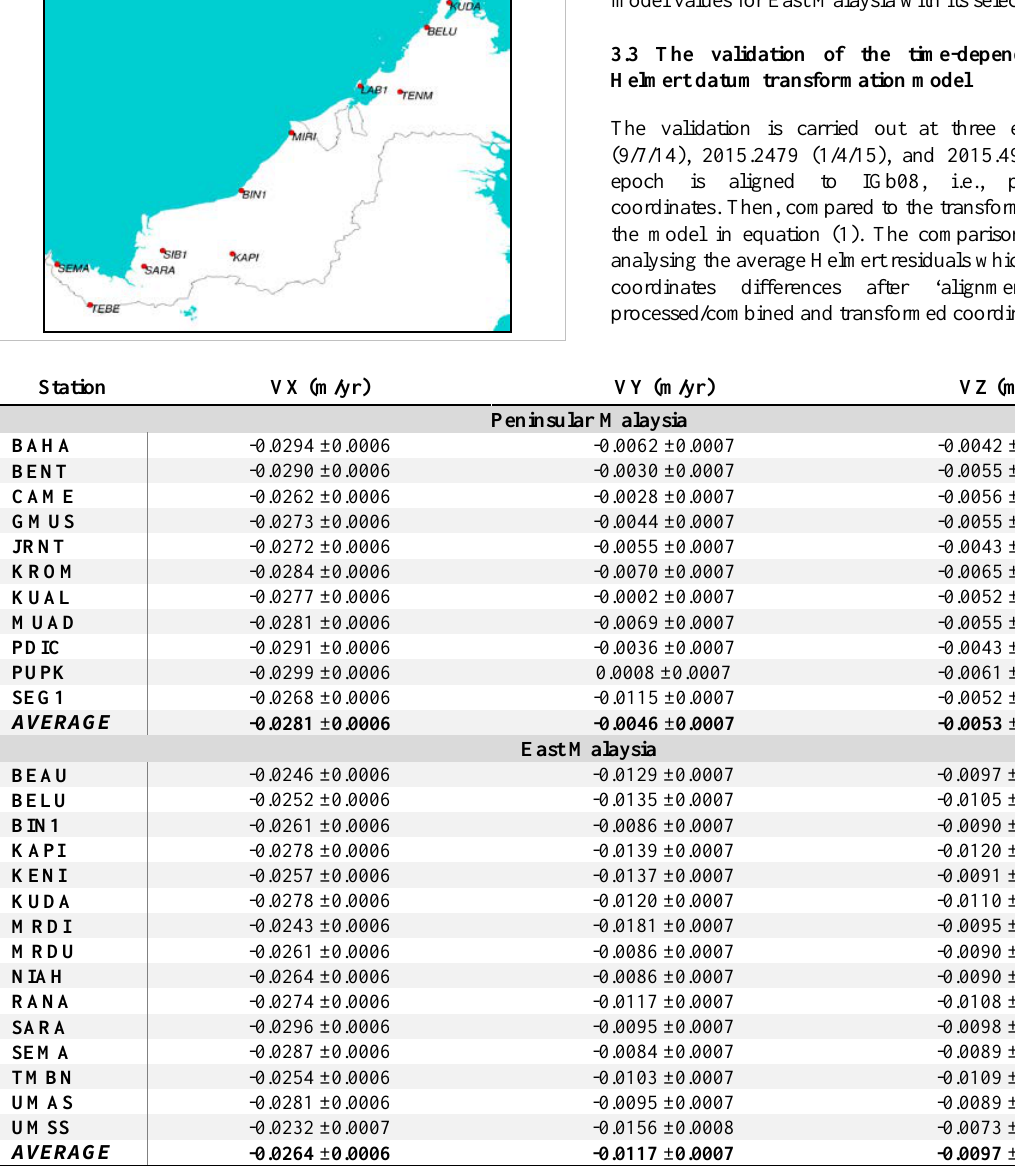
Table 6. The time-dependent 3-parameter datum transformation